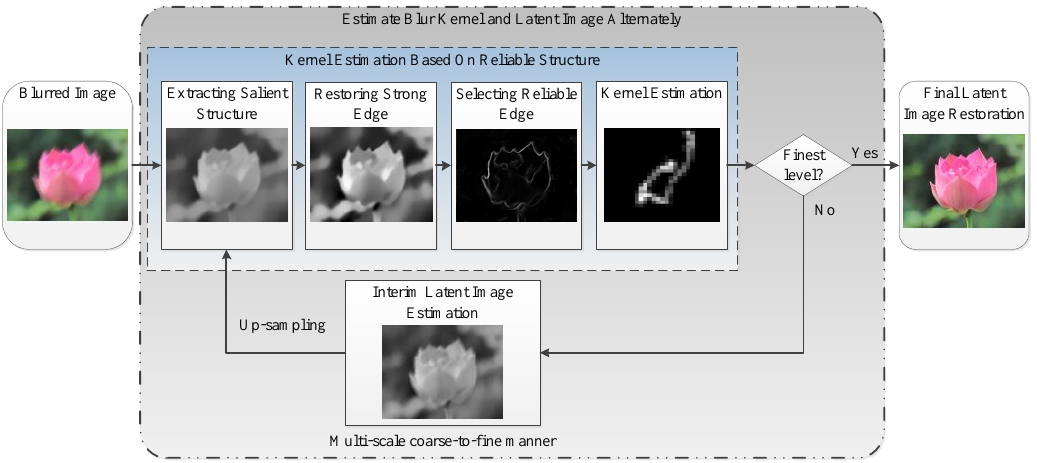
Figure 2. The flowchart of the proposed blind deconvolution algorithm.